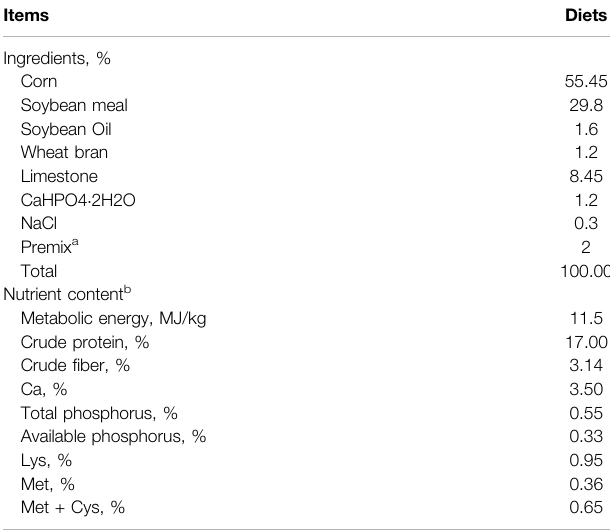
TABLE 1 | Composition and nutrient levels of basal diets (air-dry basis, %).